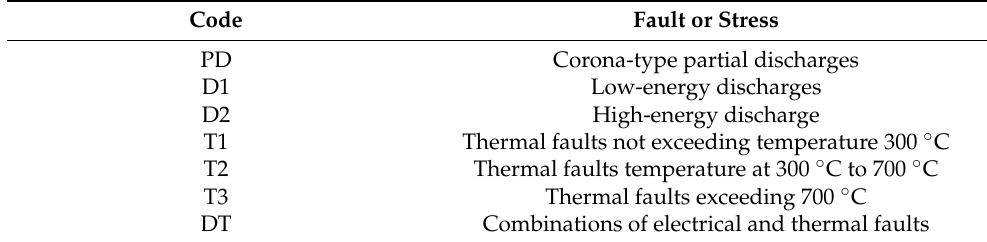
Table 5. Faults identified using the DTr-1.